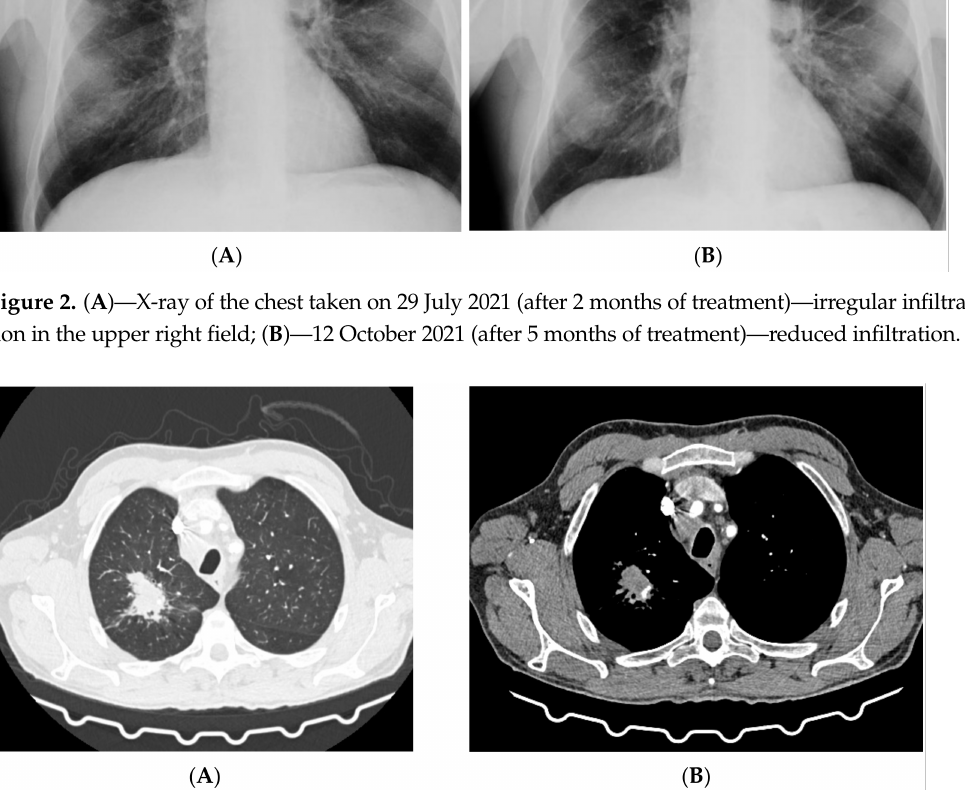
Figure 3. ( A , B )—CT scans taken during the fifth month of treatment, September